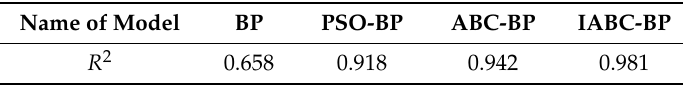
Table 4. Coefficient of determination R 2 of each model.